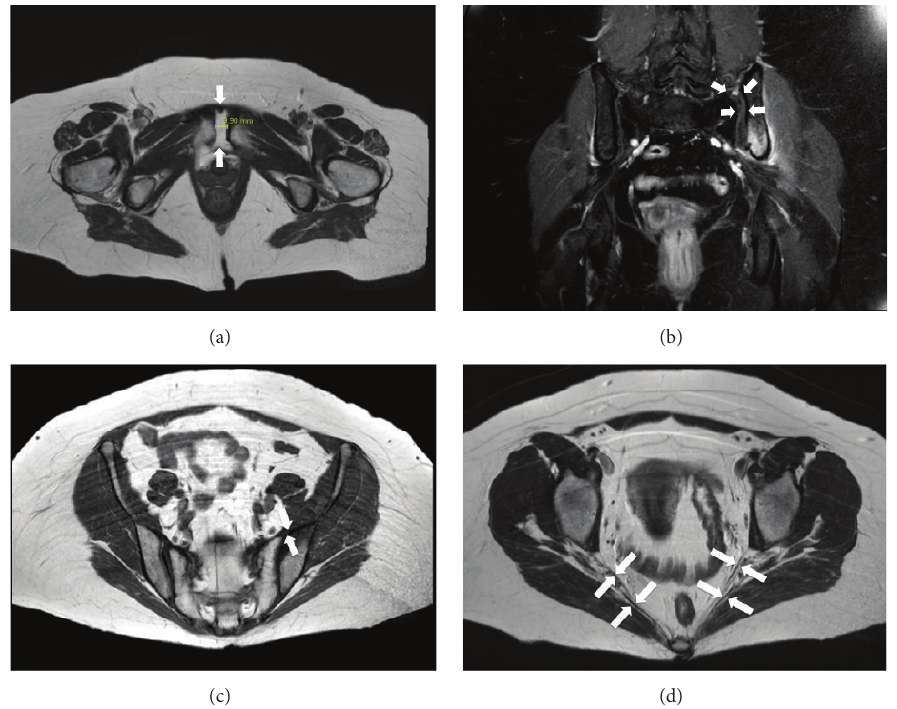
Figure 1: MRI of the pelvis. (a) Axial MRI presenting extensive widening of the symphysis about 9.9 mm (arrows). (b) Coronary MRI also showed widening of the left sacroiliac joint (arrows) and an increased signal from the left ilium. (c) Axial MRI revealed ruptured left anterior sacroiliac ligaments and intact posterior sacroiliac ligaments (arrows). (d) Axial MRI showed intact sacrotuberal and sacrospinal ligaments on both sides (arrows).